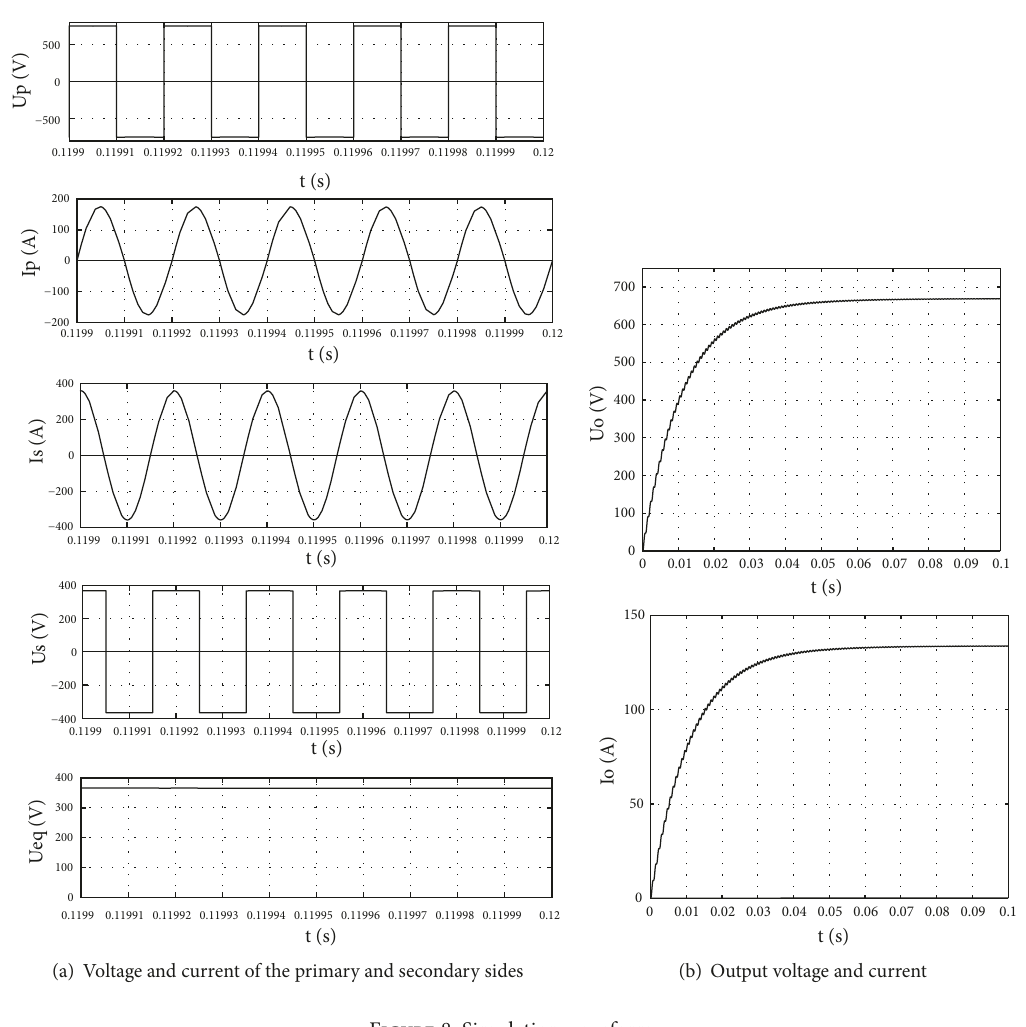
Figure 8: Simulation